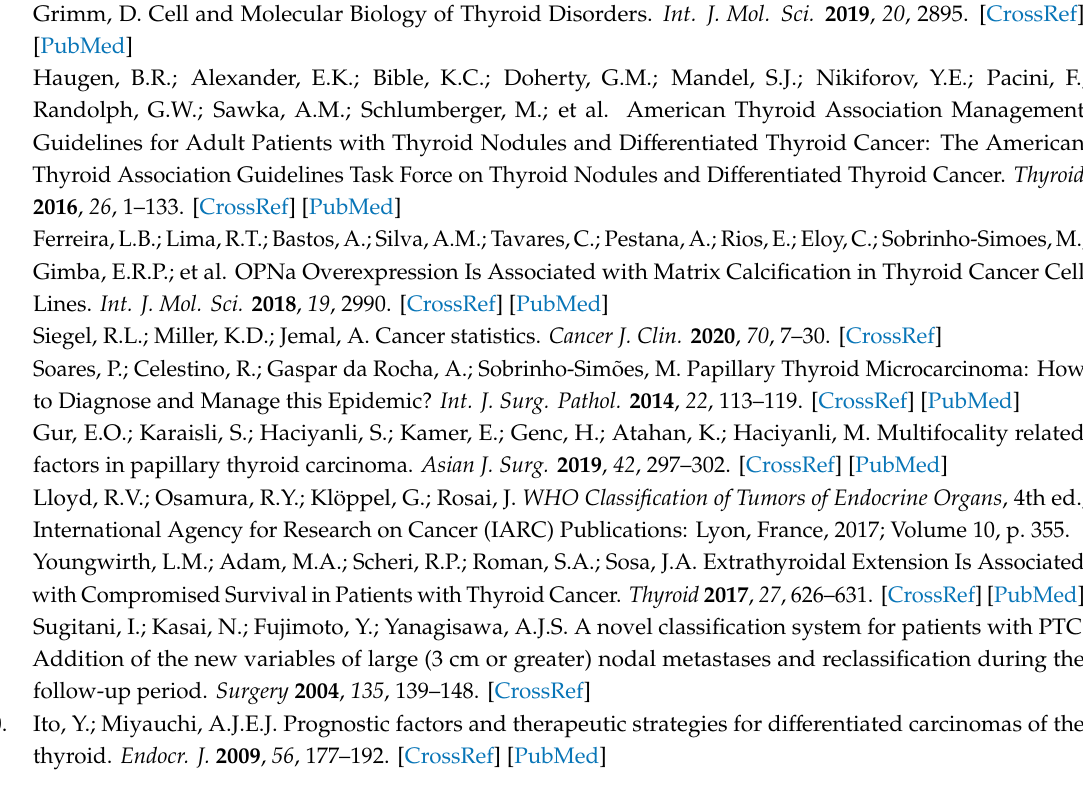
Table S1: Histopathological variables and considered criteria, Table S2: Clinicopathological features, Table S3: Clinicopathological features concerning recurrent / persistent disease, Table S4: Clinicopathological features concerning structural disease status, Table S5: Clinicopathological features concerning PTC-specific mortality. The graphical abstract was created with